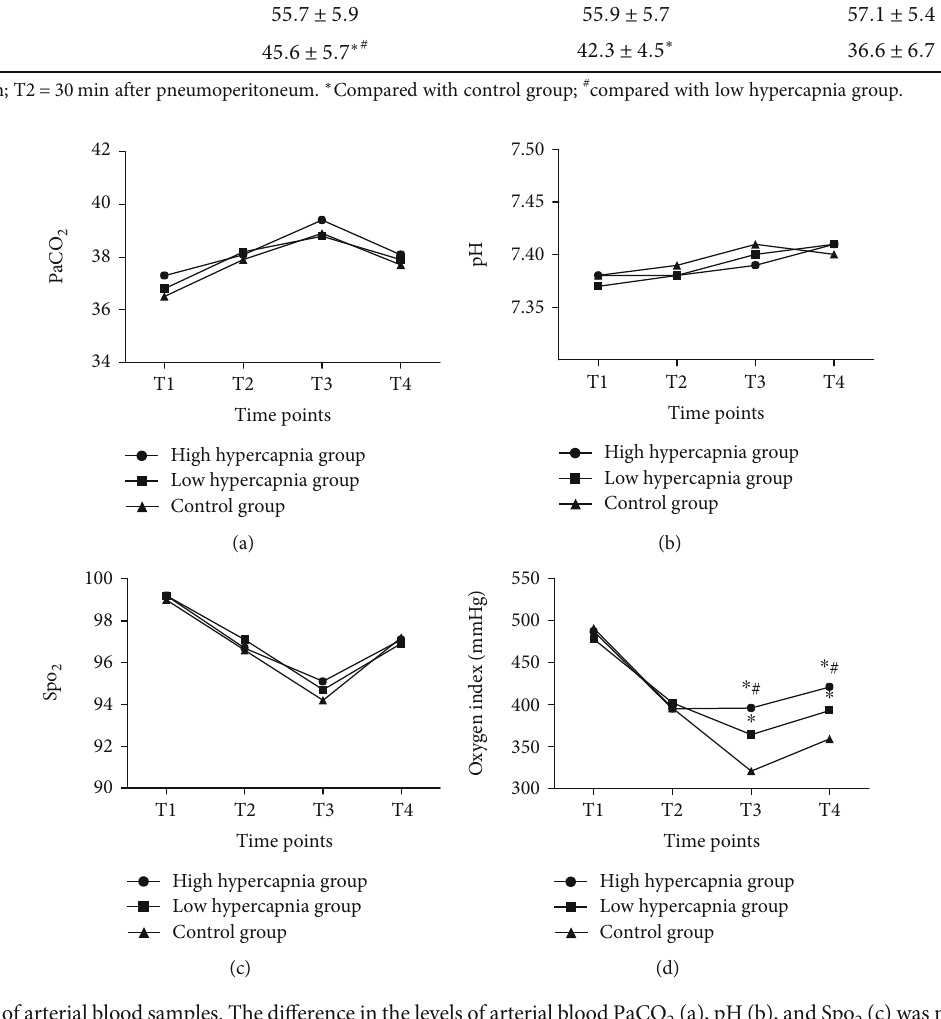
(a), pH (b), and Spo (c) was not signi fi cant at 2 2 /FiO , oxygen index) in the 2 2